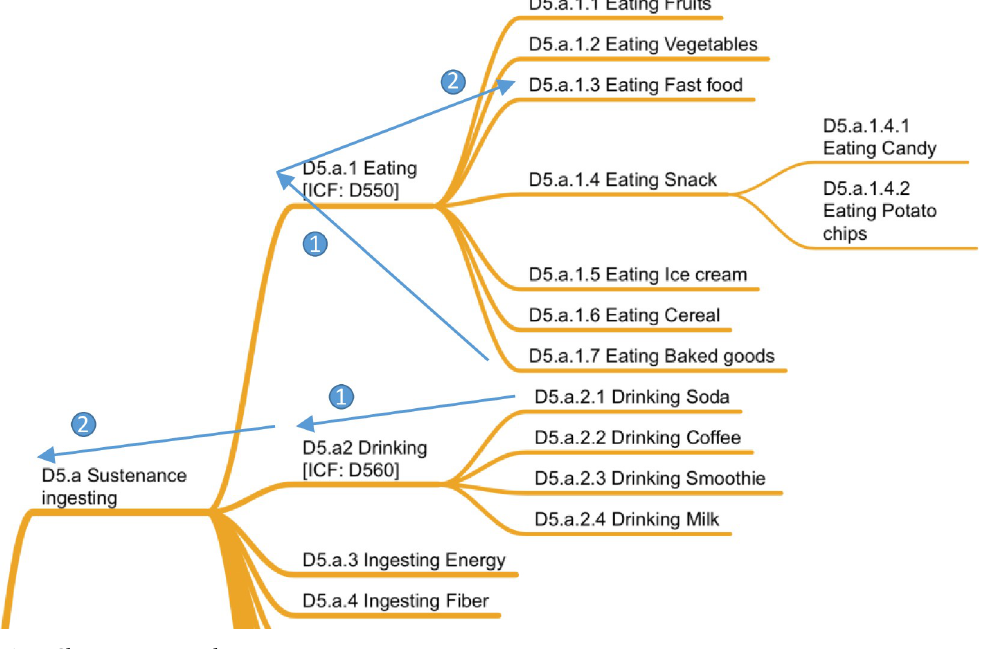
Fig 2. Close agreement